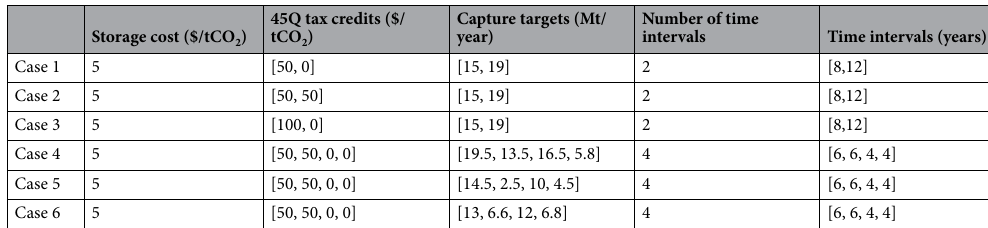
Table 3. Input data for different scenarios for the case